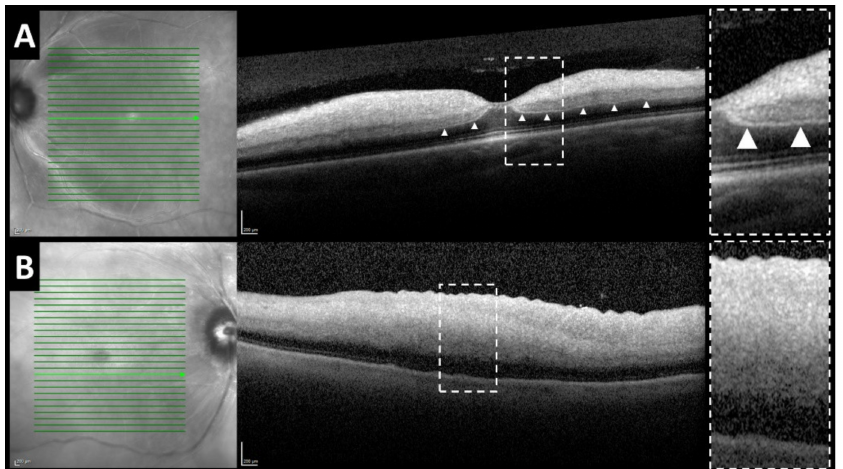
Figure 3. SD-OCT cross-sections after central retinal artery occlusion with visible p-MLM sign (( A ) arrowheads) and with maximum increase in reflectivity of the entire inner retina inhibiting identification of p-MLM sign ( B ).